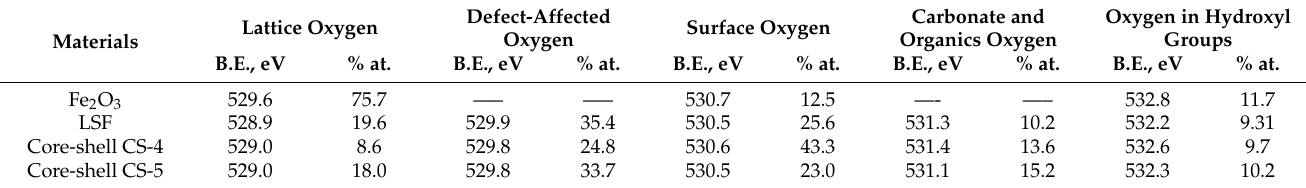
Figure 11. XPS spectra of O1s core: ( a ) LSF-perovskite; ( b ) Fe 2 O 3 calcined at 700 ◦ C and Fe 2 O 3 @LSF core-shell materials ( c ) CS-4 and ( d ) CS-5. Table 6. Oxygen species detected by XPS in as-prepared